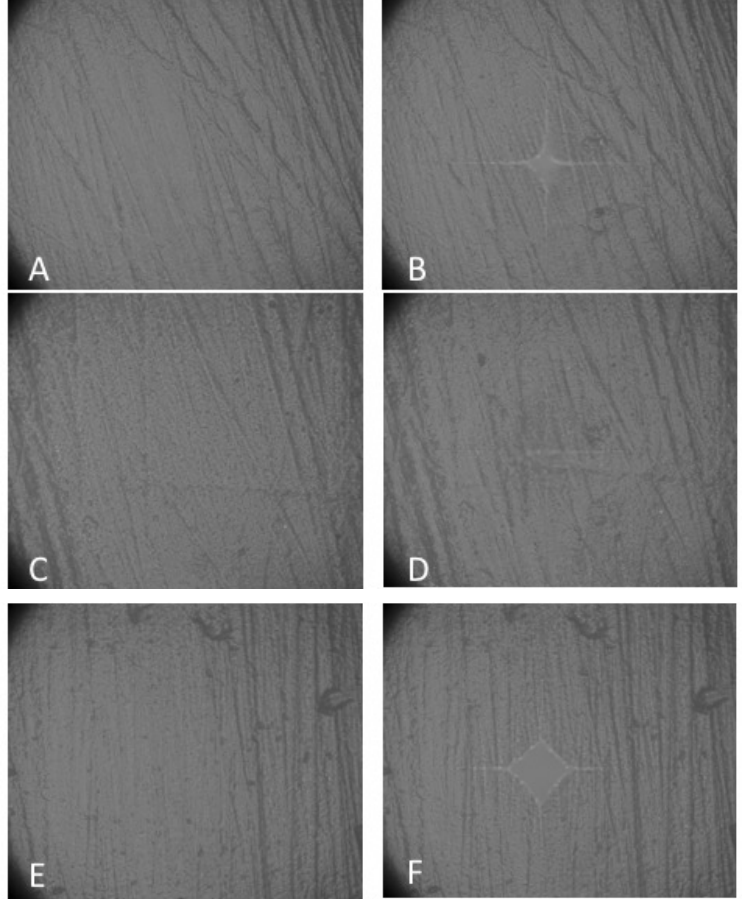
Figure 2. Photomicrographs of hybrid ceramic (CERASMART ™ ) before and after immersion in acidic drink for 7 and 28 days (40× magnification). ( A , B ) Before immersion; ( C , D ) after immersion in acidic drink for 7 days, ( E , F ) after immersion in acidic drink for 28 days.